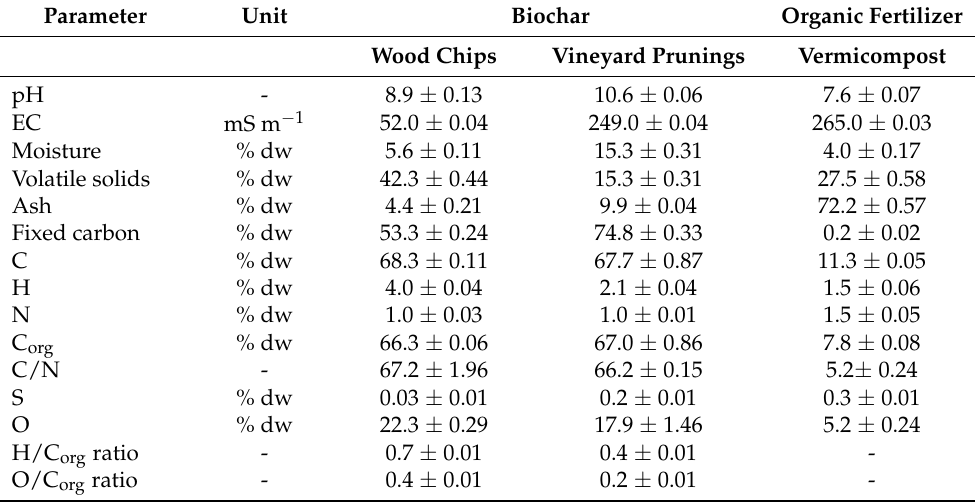
Table 2. Chemical properties of the two biochars and the organic fertilizer used in the experiment. Parameter Unit Biochar Organic Fertilizer Wood Chips Vineyard Prunings Vermicompost pH - 8.9 ± 0.13 10.6 ± 0.06 EC mS m − 1 Moisture % dw 5.6 ± 0.11 Volatile solids % dw Fixed carbon %